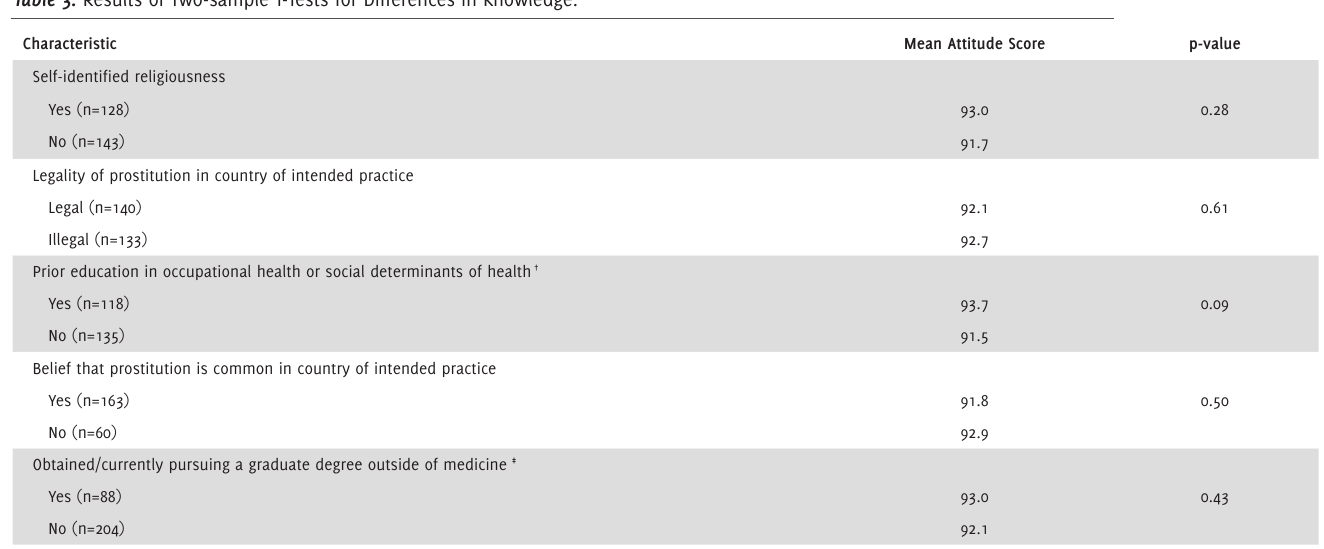
Table 3. Results of Two-sample T-Tests for Differences in Knowledge. +